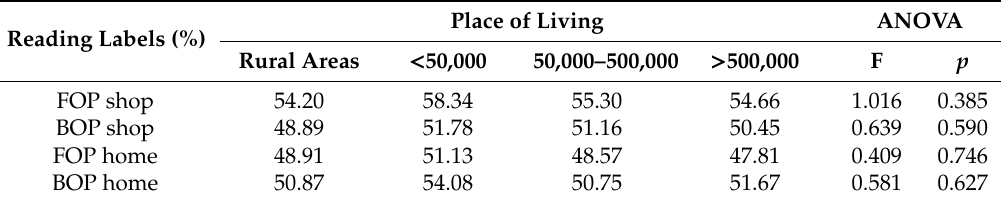
Table 3. Reading food labels by the place of